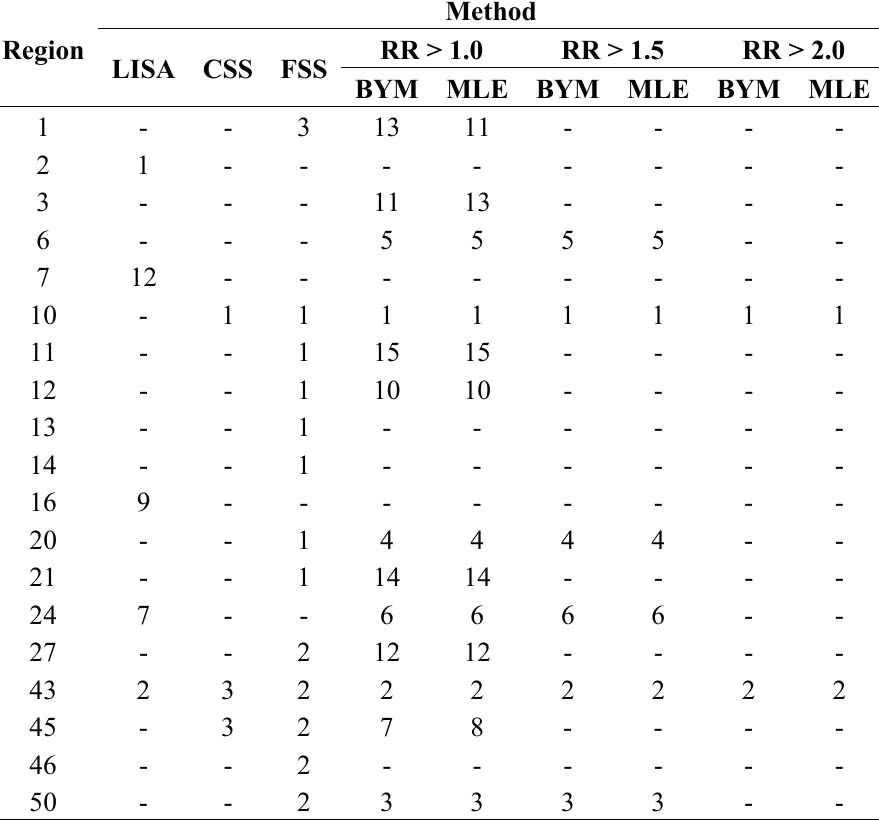
Table 1. The order of significant regions for the LISA, CSS, FSS, BYM, and MLE methods for cluster